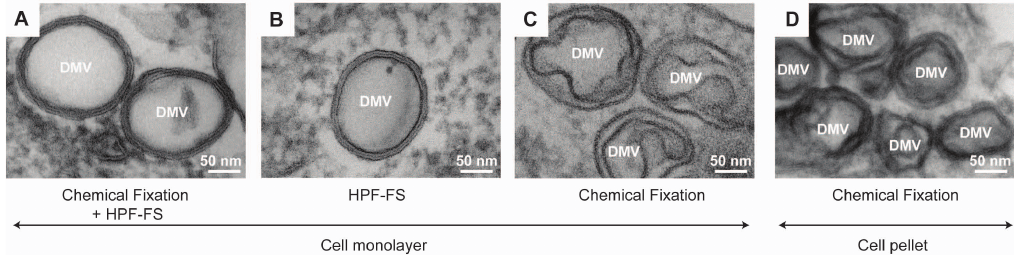
Figure 2. Impact of different fixation methods on the morphology of double membrane vesicles (DMVs) induced by Hepatitis C Virus (HCV). ( A ) Huh7 cells grown on sapphire discs were infected with HCV and processed after chemical fixation by high pressure freezing (HPF) and freeze substitution (FS); ( B ) Huh7 cells were transfected by electroporation with a subgenomic HCV replicon RNA and 48 h later subjected directly to HPF-FS without chemical fixation. DMVs were also found in high abundance in these samples excluding that they are an artifact caused by chemical fixation. Also note the minimal extraction of the cytosol surrounding the DMVs and their content in comparison to chemically fixed cells; ( C ) HCV-infected Huh7.5 cells grown on coverslips were chemically fixed and then embedded in epon; ( D ) Huh7.5 cells were infected with HCV and 48 h later cells were fixed, scraped off the culture dish and sedimented by gentle centrifugation prior to embedding of the cell pellet in epon resin. Note the “fried-egg”-like morphology of the DMVs observed in chemically fixed cells ( C , D ), in comparison to the very well-delineated membranes of cells subjected to HPF ( A , B ). EM micrographs were taken with permission from Romero-Brey et al.